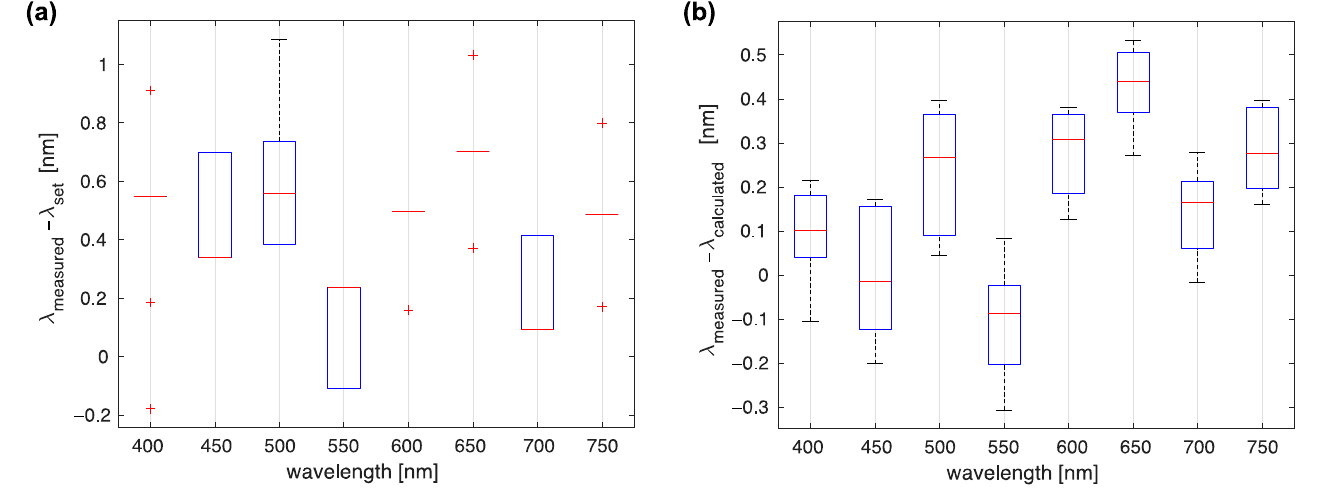
Figure 5. Monochromator wavelength selection repeatability. ( a ) Differences between the requested and spectrometer-measured wavelengths. ( b ) Differences between the wavelengths obtained from the calibrated encoder position compared to the spectroscopy results.